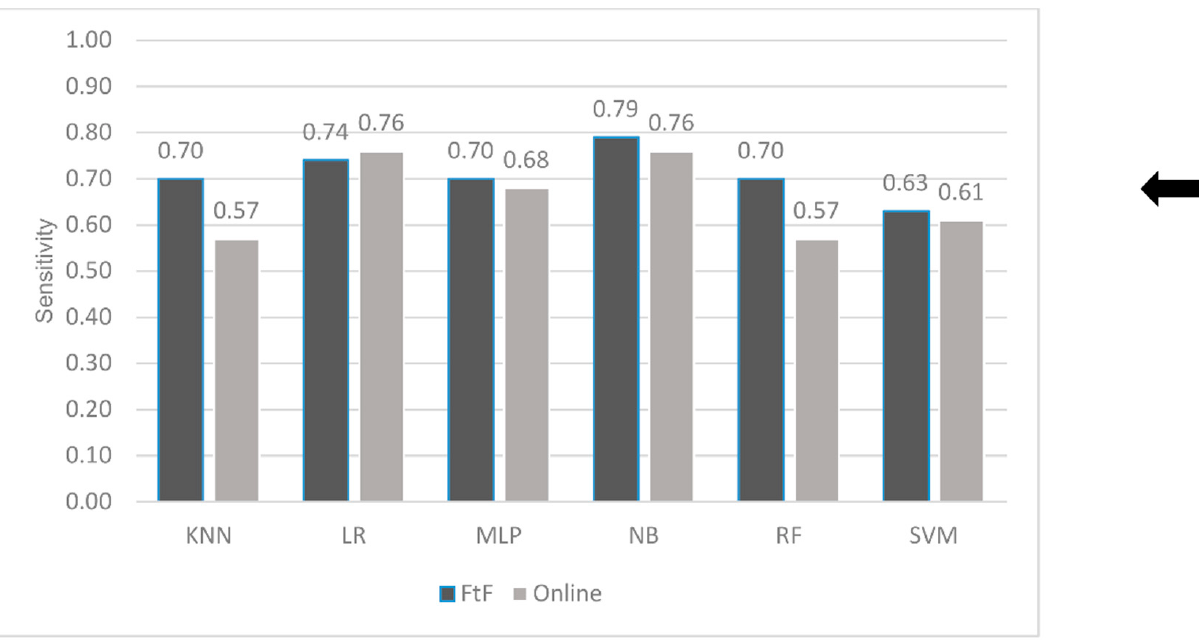
Figure 4. WCO course: prediction of at ‐ risk students (sensitivity scores) by instructional mode.